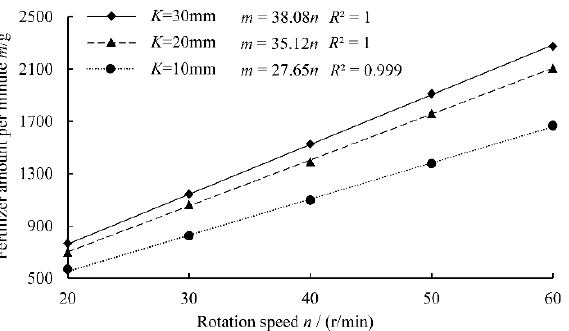
Figure 8. Effect of the rotation speed on the fertilizer amount per minute. Table 7. Results of coefficient of variation of fertilization stability (CVFS) determination tests.